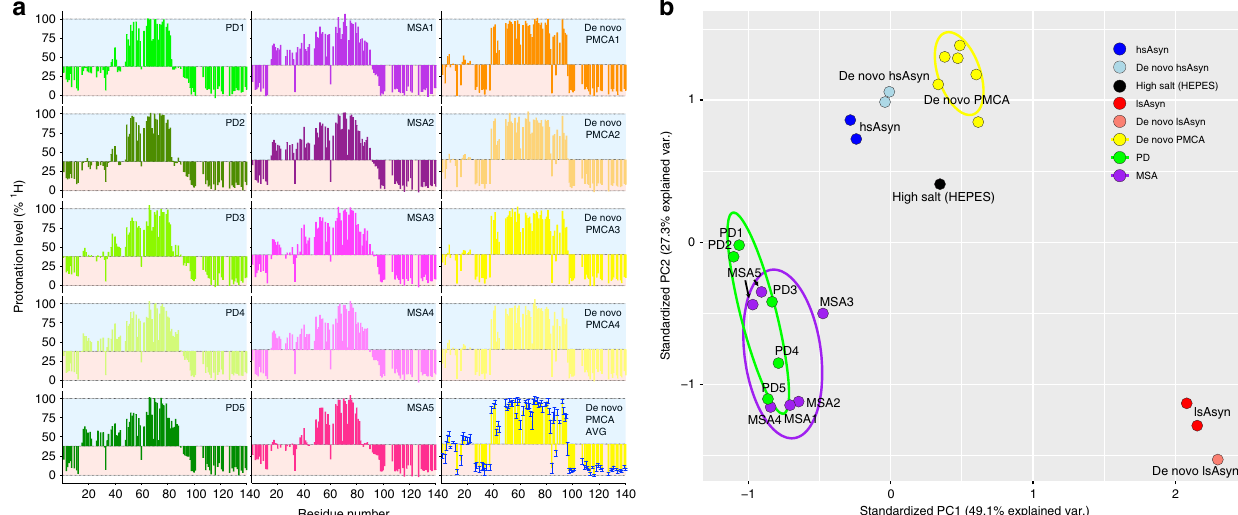
Fig. 5 Molecular level insights into the structure of aSyn fi brils ampli fi ed from patient brain extracts. a HD-exchange pro fi les of aSyn fi brils ampli fi ed from brain extracts of PD patients (left, green) and MSA patients (middle, purple). HD-exchange pro fi les of four de novo PMCA aSyn fi brils, which are not based on seeding/propagation, are shown in the right column (yellow to orange) together with the residue-speci fi c average values for six de novo PMCA fi bril samples. Error bars represent std. b PCA of protonation levels in aSyn fi brils (see text for further details). Independent repetition of HD exchange measurements for fi brils obtained from patient MSA5 are included (indicated by black